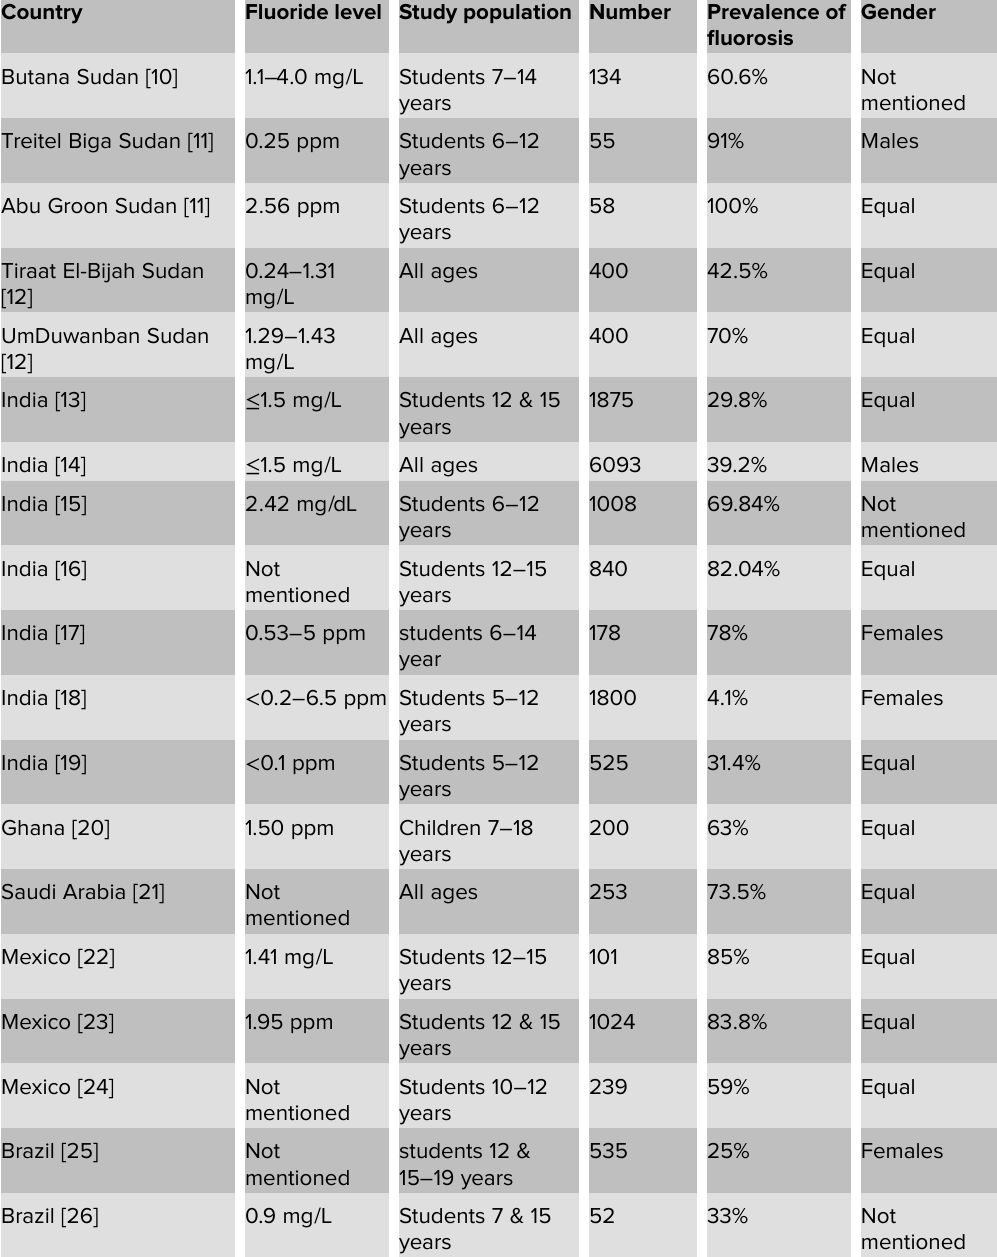
TABLE 3: Summary of previous studies on the prevalence of dental